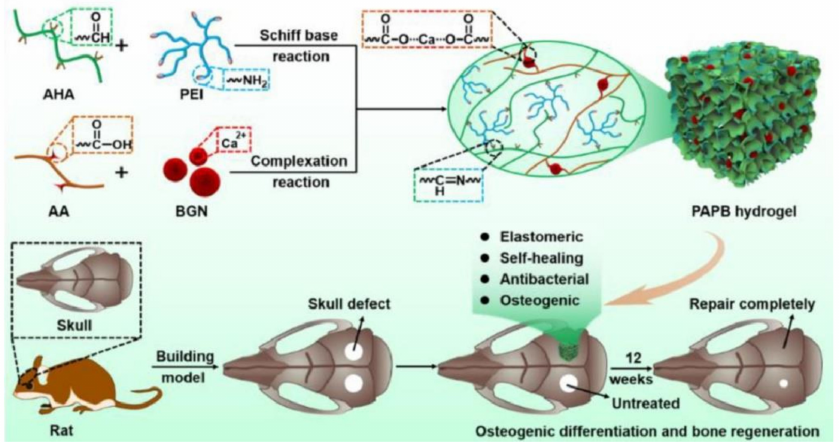
Figure 3. Elastomeric self-healing antibacterial bioactive nanocomposites scaffolds for treating skull defect [63]. Reproduced with permission from Li, Y, Appl. Mater. Today; published by Elsevier, 2022. X. Lu et al. [64] prepared self-healing hydrogels by combining chitosan with silk fibroin (SF) through hydrogen bond, ion interaction (Mg 2+ ), amide bond. Chitosan@SF hydrogels delivered and released recombinant human bone morphogenic protein-2 (rhBMP- 2)/rat bone marrow-derived MSCs (rBMSCs) using the three-site network structure of